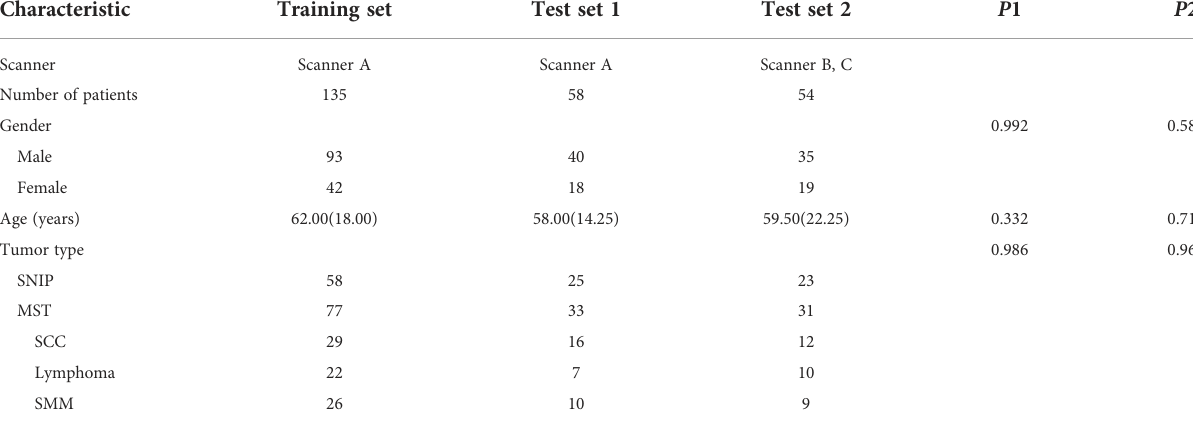
P 1 represent the P values of comparison between training set and test set 1. P 2 represent the P values of comparison between training set and test set 2. SNIP, sinonasal inverted papilloma; MST, malignant sinonasal tumor; SCC, squamous cell carcinoma; SMM, sinonasal malignant